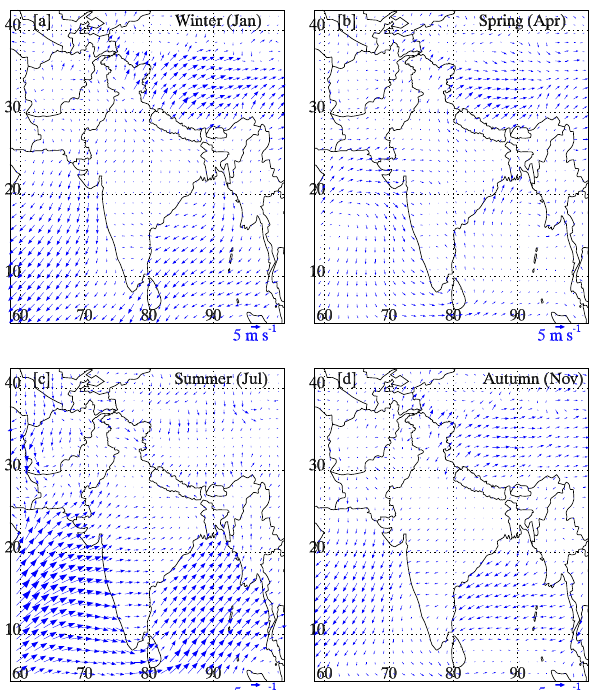
Fig. 3. Simulated average wind vectors over the model domain dur- ing (a) January, (b) April, (c) July and (d) November. The wind vectors are shown at every third grid point (135km) for the clarity.